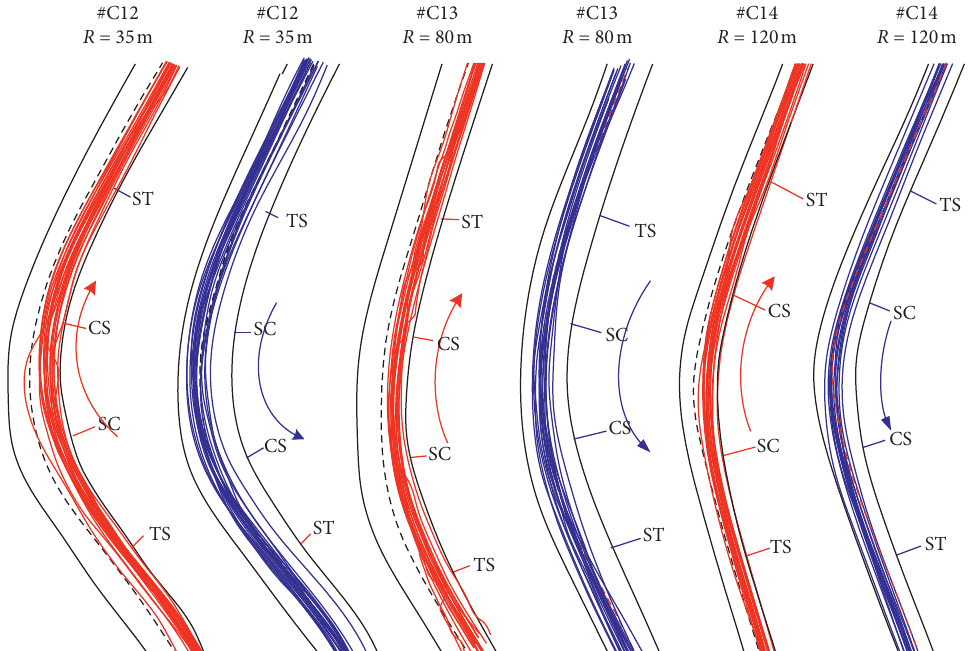
Figure 15: Vehicle track measured on three general curves with different radius. General curves